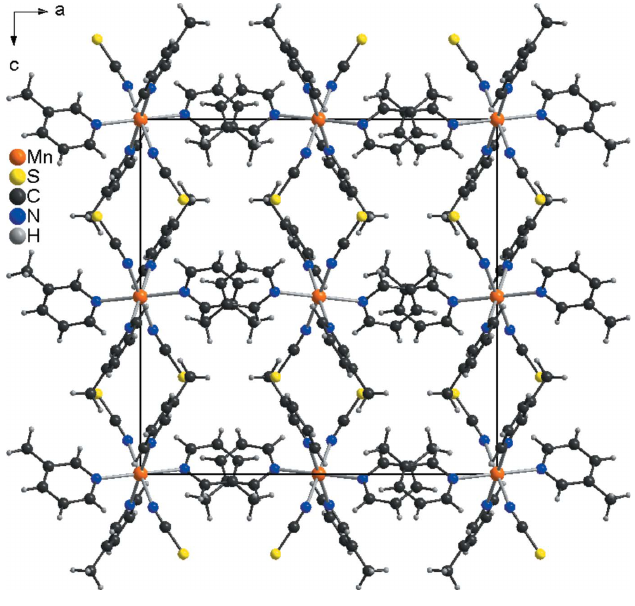
Figure 5 The packing of compound 1 viewed along the crystallographic b